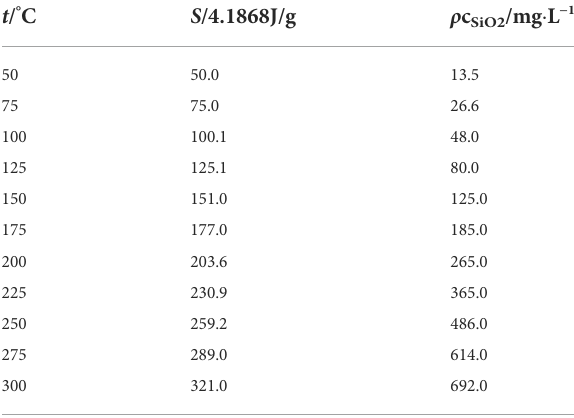
TABLE 5 Relationship of water temperature, enthalpy, and SiO 2